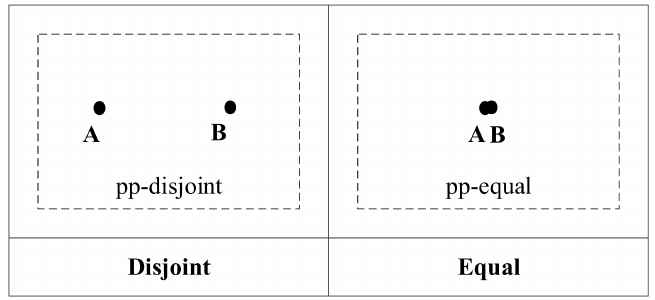
Figure 3. Topological relations between two points.